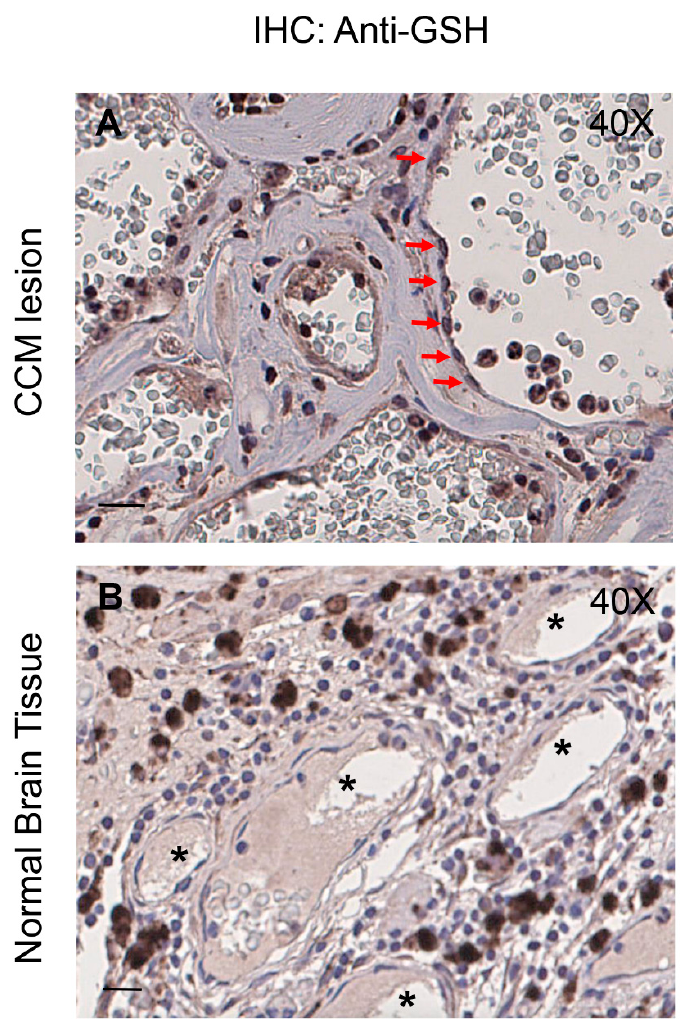
Figure 8. Increased levels of S -glutathionylated proteins occur in endothelial cells lining human CCM lesions. Immunohistochemical (IHC) analysis of S -glutathionylated proteins in histological sections of a representative human CCM surgical specimen containing a cluster of CCM vessels ( A ) and perilesional normal vessels serving as internal negative controls ( B ). Scale bar: 200 µ m. Notice that a significant positive IHC staining for S -glutathionylated proteins is evident in endothelial cells lining the lumen of CCM lesions (A, arrows), as compared with endothelial cells lining the lumen of perilesional normal vessels (B, asterisks).